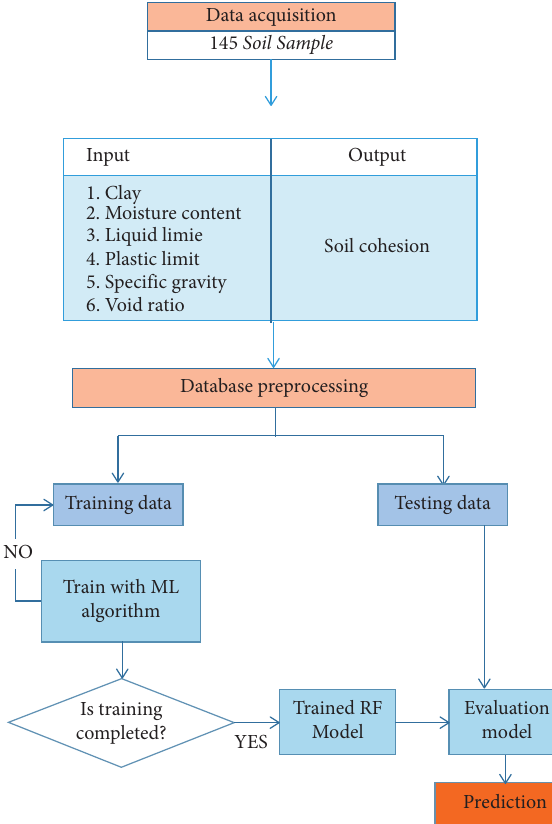
Figure 4: Methodology flow chart of the present